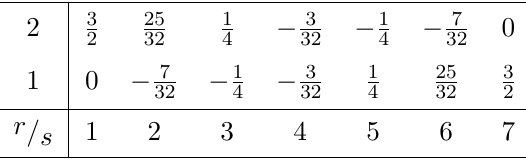
Table 16 . The representations of the Virasoro algebra at c = (cid:0) 21 =